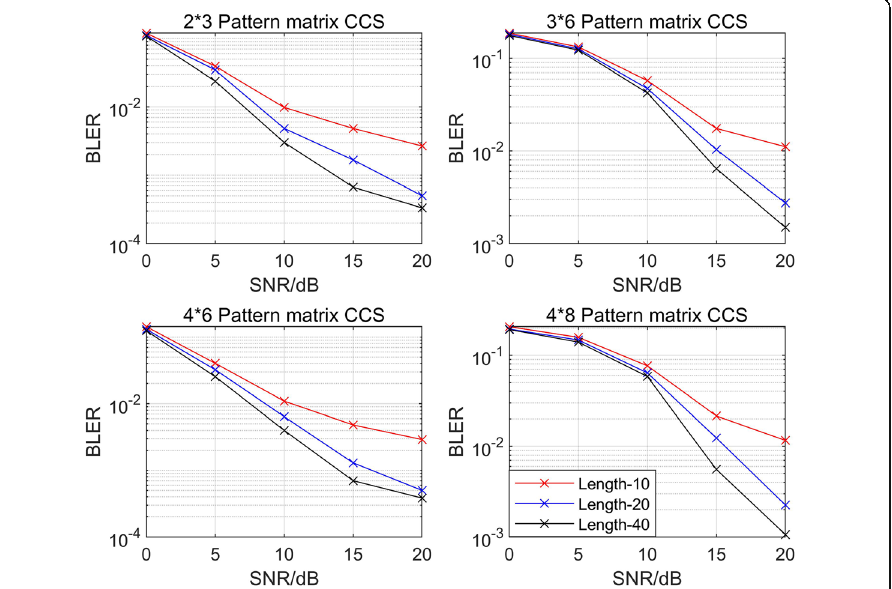
Fig. 5 CCS spread spectrum based on PDMA pattern matrix with different dimensions. The spread spectrum performance comparison of CCS with length of 10, 20, and 40 under different dimensional pattern